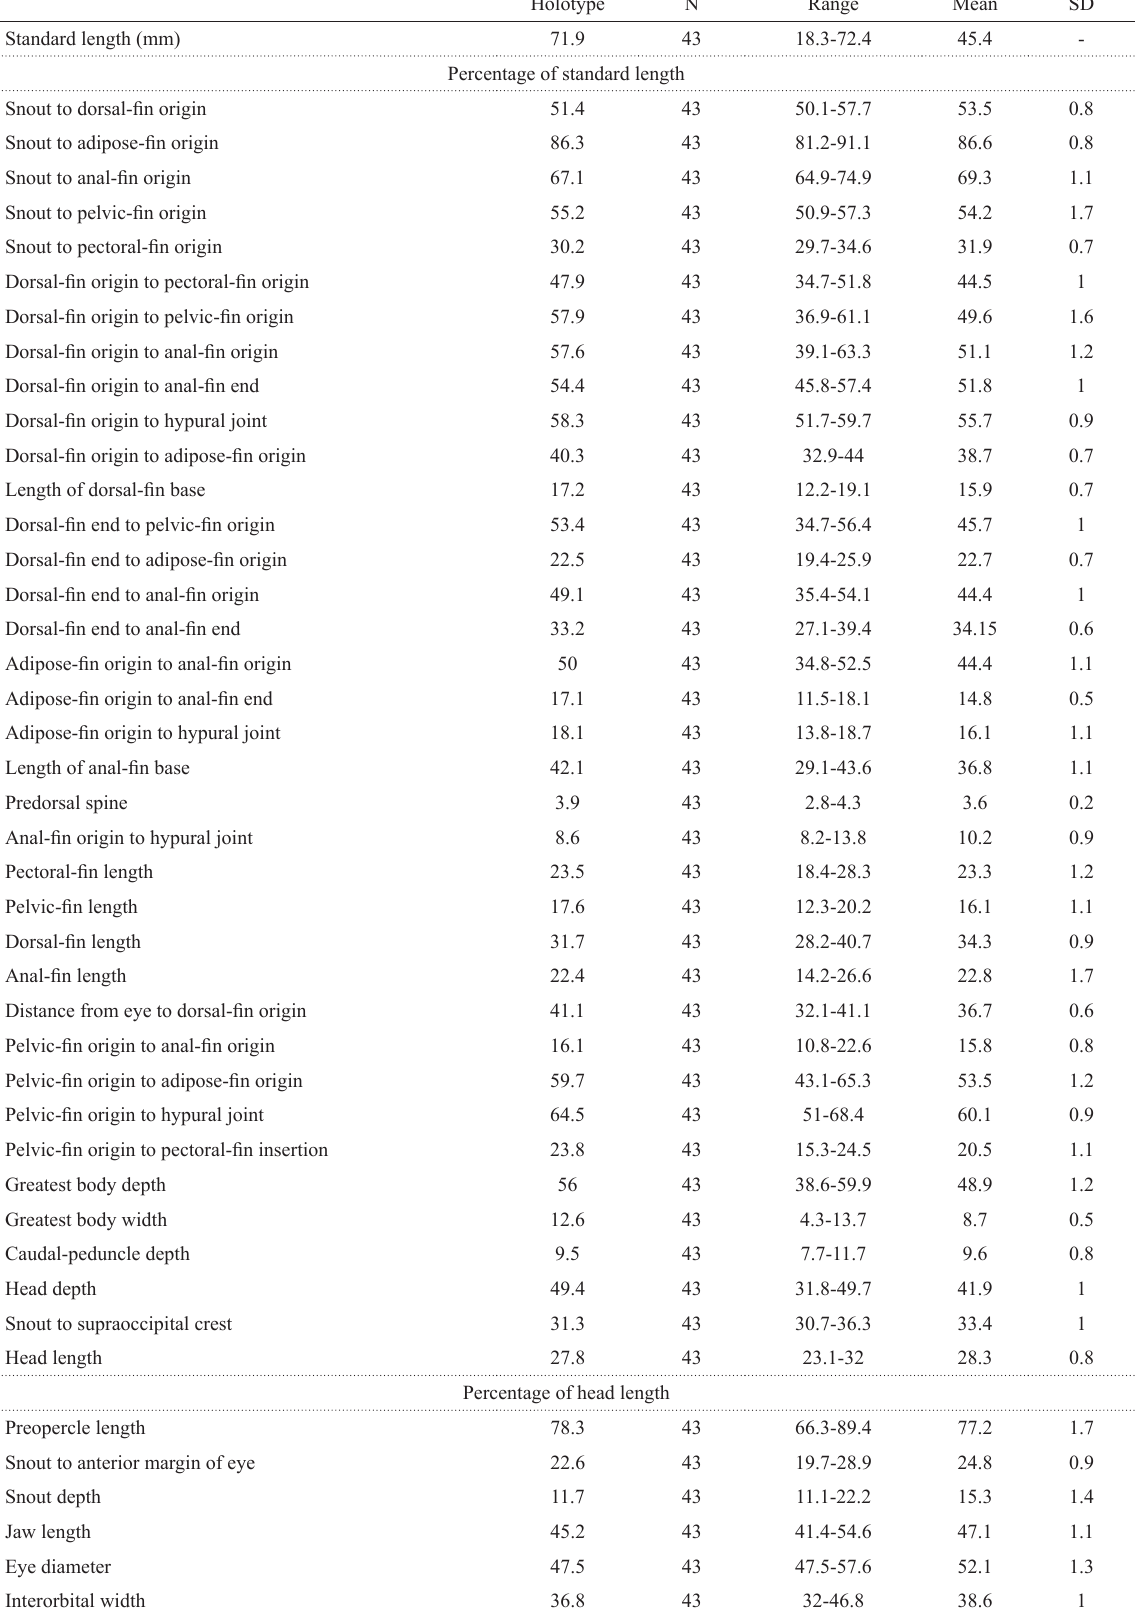
Tab. 1. Morphometric data of Poptella actenolepis . Range includes holotype. SD = Standard deviation. Holotype N Range Mean SD Standard length (mm)